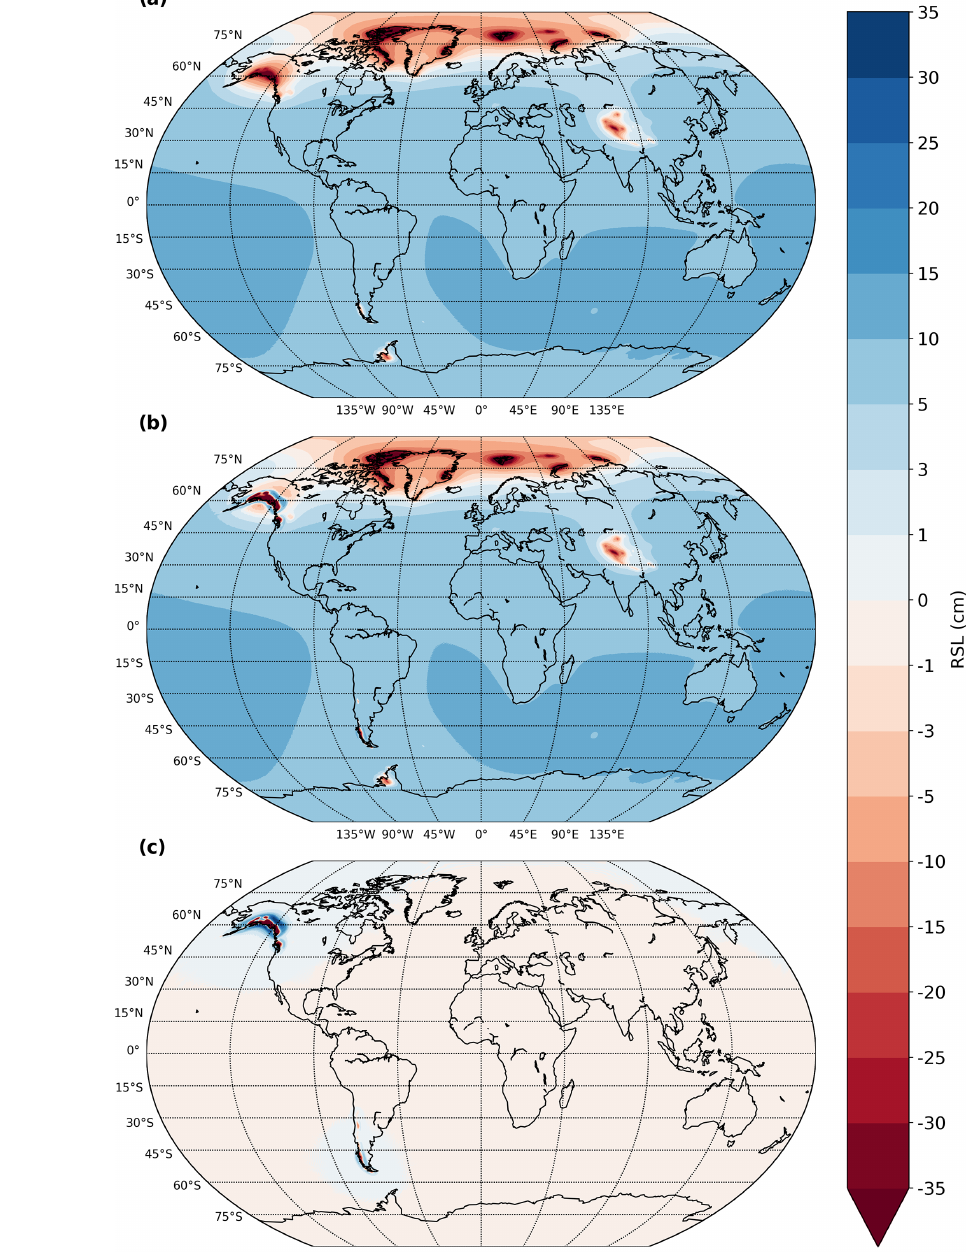
Figure 3. Calculated sea-level fingerprints for estimated changes in global glacier distribution from 2010 to 2100CE for (a) a 1D (spherically symmetric) elastic Earth model and (b) a 3D viscoelastic Earth model with low-viscosity regions located as indicated in Fig. 2. (c) The difference between the viscoelastic and elastic results (i.e. b minus a